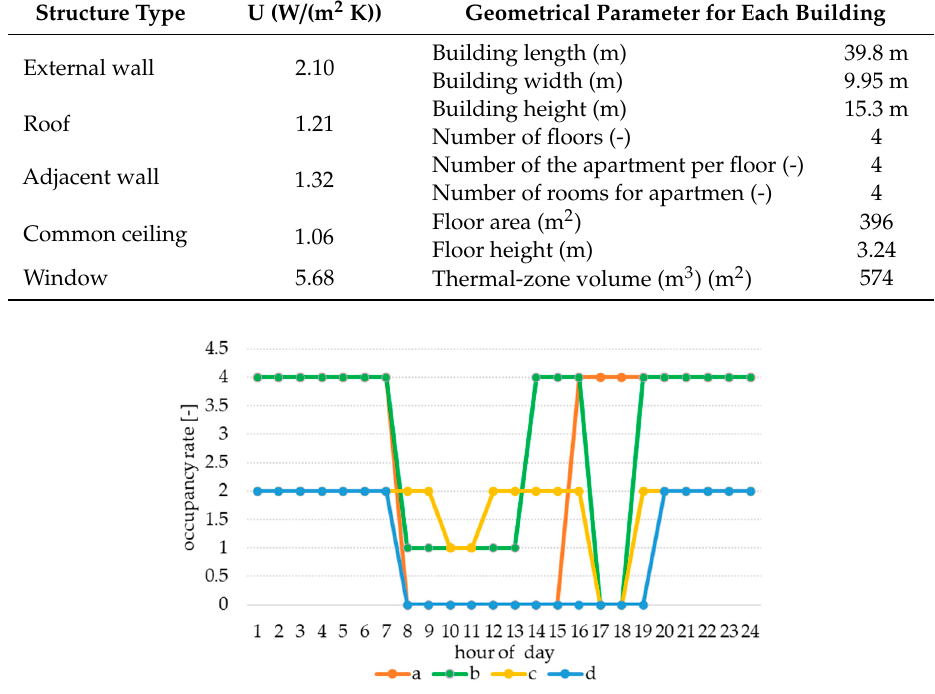
Table 2. Building envelope and geometric parameters.